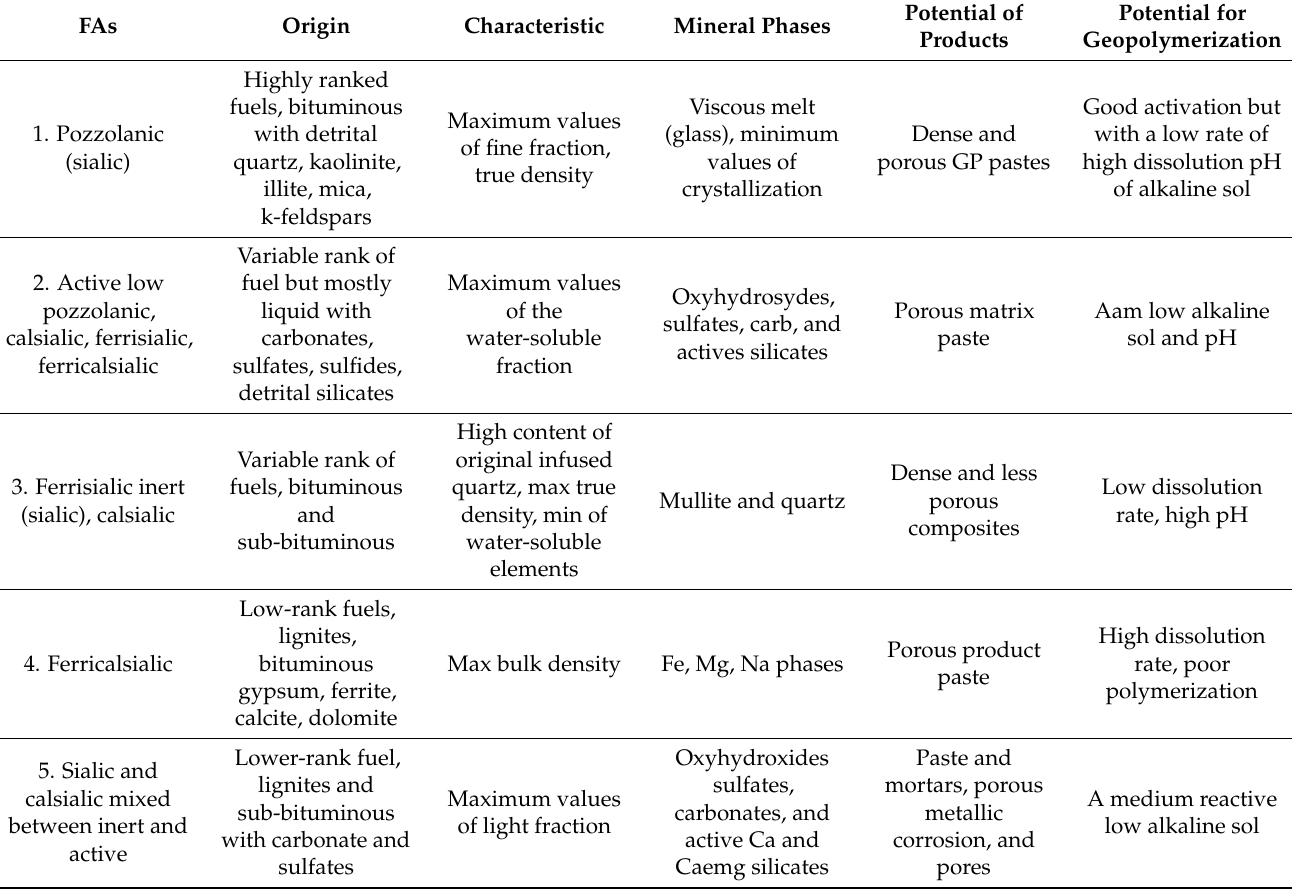
Table 1. FA classification and applications for the production of inorganic GPs. Adapted from [91].